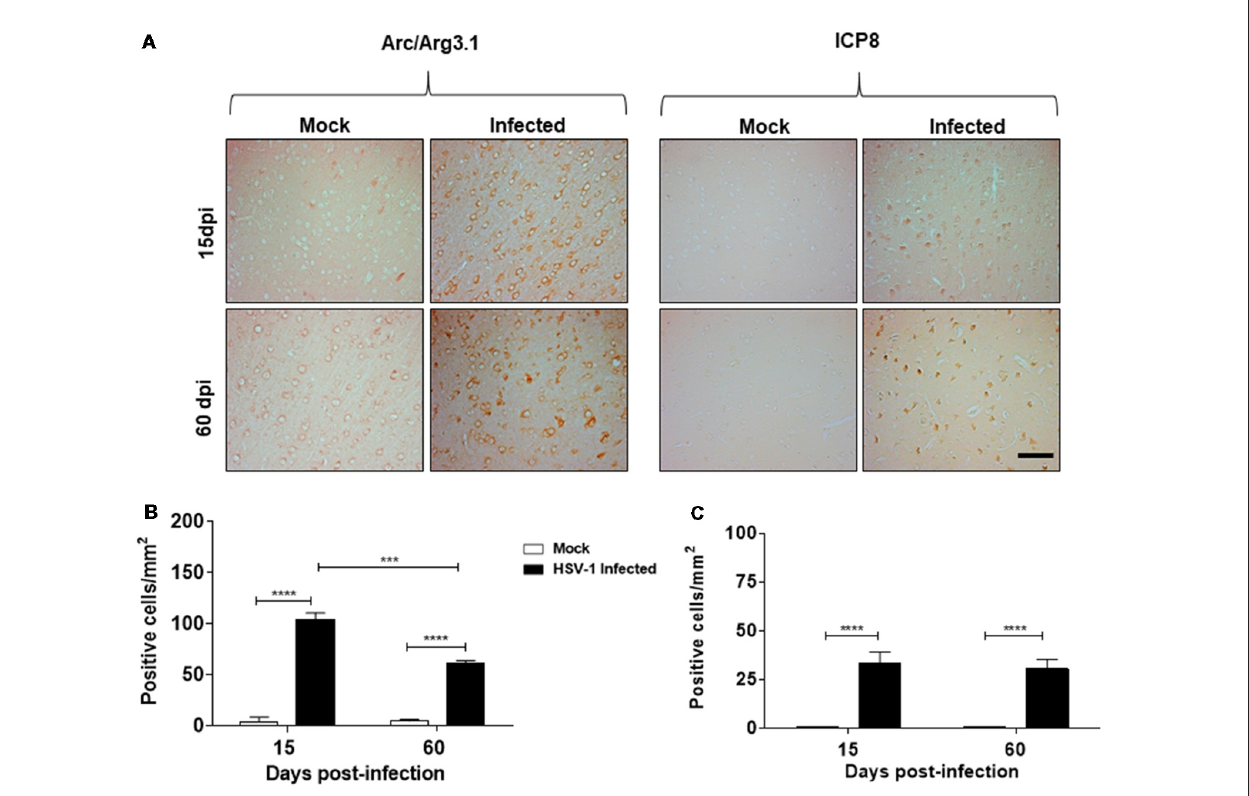
FIGURE 1 | Herpes simplex virus type 1 (HSV-1)-infected mice present elevated levels of Arc protein. (A) Cortexes from mock and HSV-1 infected mice (six animals per time and condition) were stained at 15, 60 days post-infection (dpi) post-infection with antibodies to Arc and to ICP8 (three slices per animal). Magnification 100 × , scale bar represents 100 nm. (B,C) Graphics show the number of Arc/ICP8 positive cells/mm 2 ( n = 3 sections per times). ∗∗∗∗ p < 0.0001 and ∗∗∗ p < 0.001 [analyzed by Two-Way analyses of variance (ANOVA)]. Statistical analyses between mock times to Arc and ICP8 were not significant. Also were not significant to ICP8 in infected times at 15 dpi compared to 60